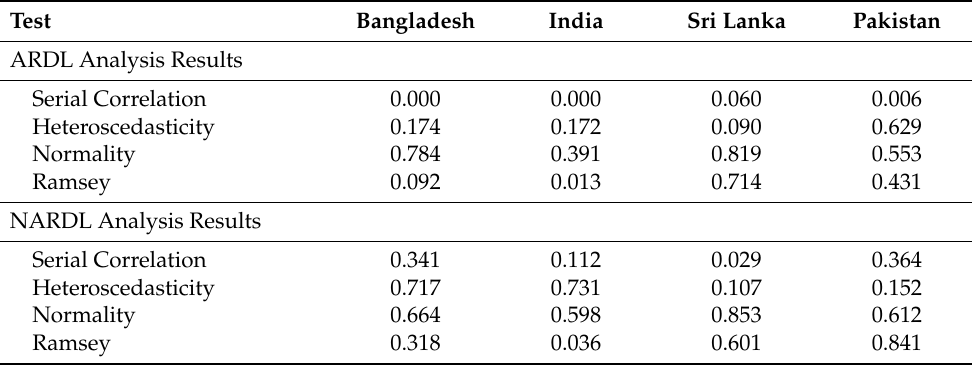
Table 6. Diagnostic checks of the ARDL and NARDL